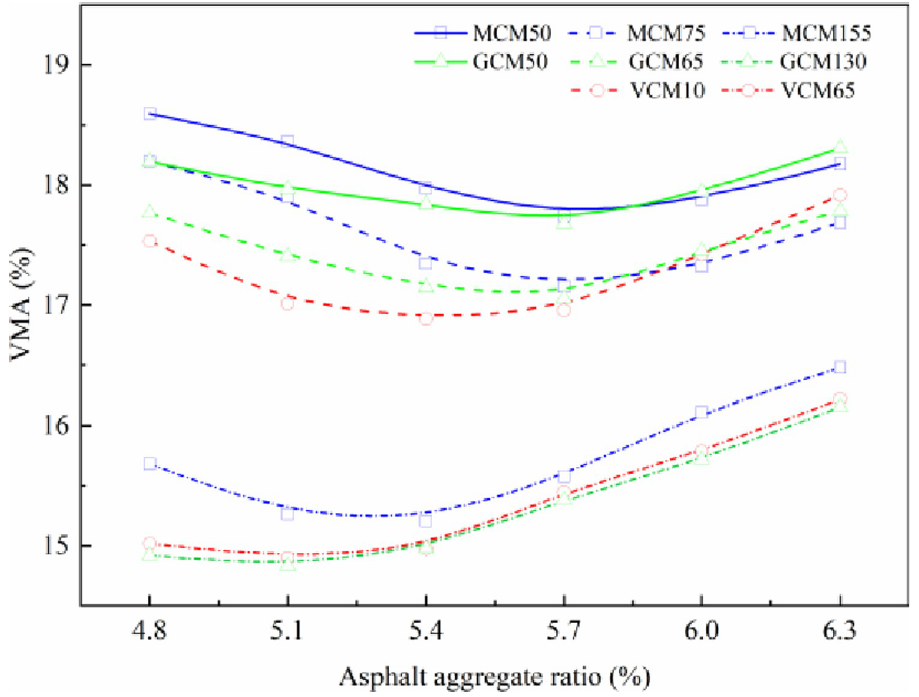
Fig 5. The relationship curve between VMA and asphalt aggregate